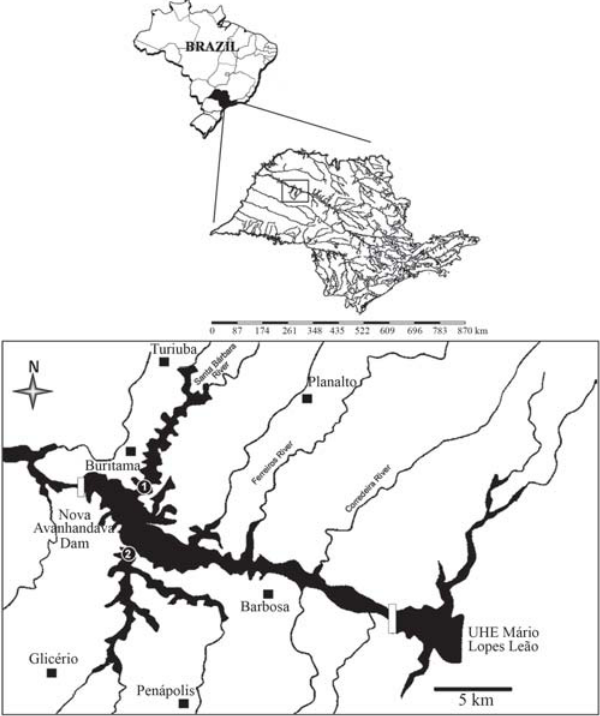
Fig. 1. Position of the Nova Avanhandava Reservoir in the Tietê River, and the location of the sampling stretches: Santa Bárbara stretch (1) and Bonito Stretch (2) (modified from CESP, 1998). Squares = municipalities of São Paulo